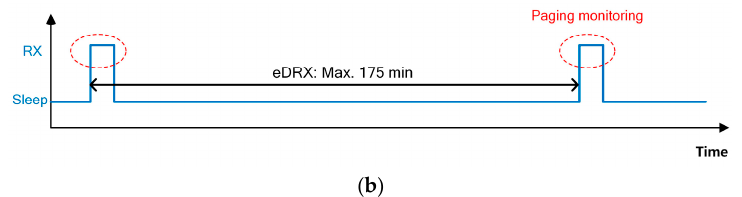
Figure 5. User equipment (UE) power state: ( a ) discontinuous reception (DRX); ( b ) extended discontinuous reception (eDRX).